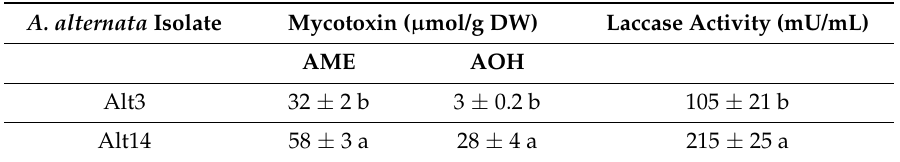
Table 1. Alternariol (AOH) and alternariol monomethyl ether (AME) and laccase activity levels in Alt3 and Alt14 isolates of A. alternate mycelia (15-days-old). The data represent mean values ± SE ( n = 3) of these mycotoxins ( µ mol/g DW). Values not sharing a common superscript letter are significantly different ( P <